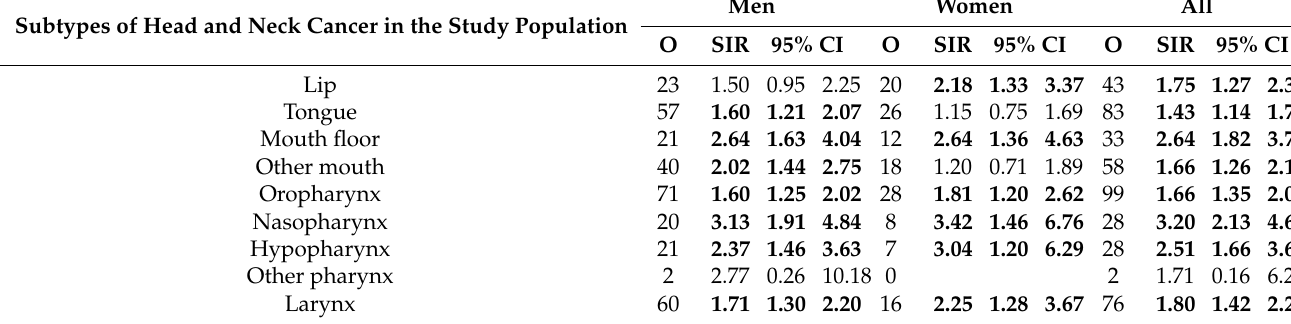
Table 3. Familial risk of site-specific head and neck cancers when first-degree relatives were diagnosed with head and neck cancers.